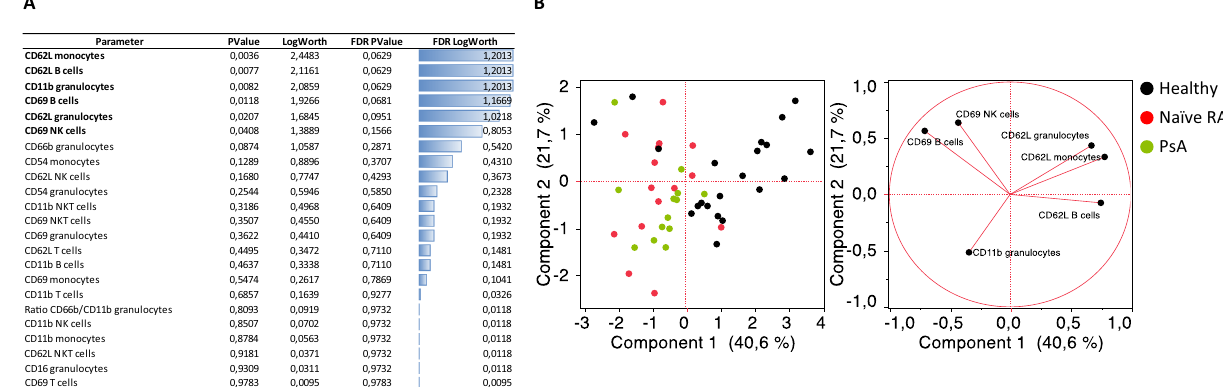
Figure 1. Most discriminative basal immunophenotypic markers between healthy donors, naïve to treatment RA and PsA patients. ( A ) Response screen of basal Mean Fluorescent Intensities (MFIs) ranking all parameters according to their ability to discriminate healthy from naïve RA patients. ( B ) Principal component analysis considering most discriminative features only (p-value <